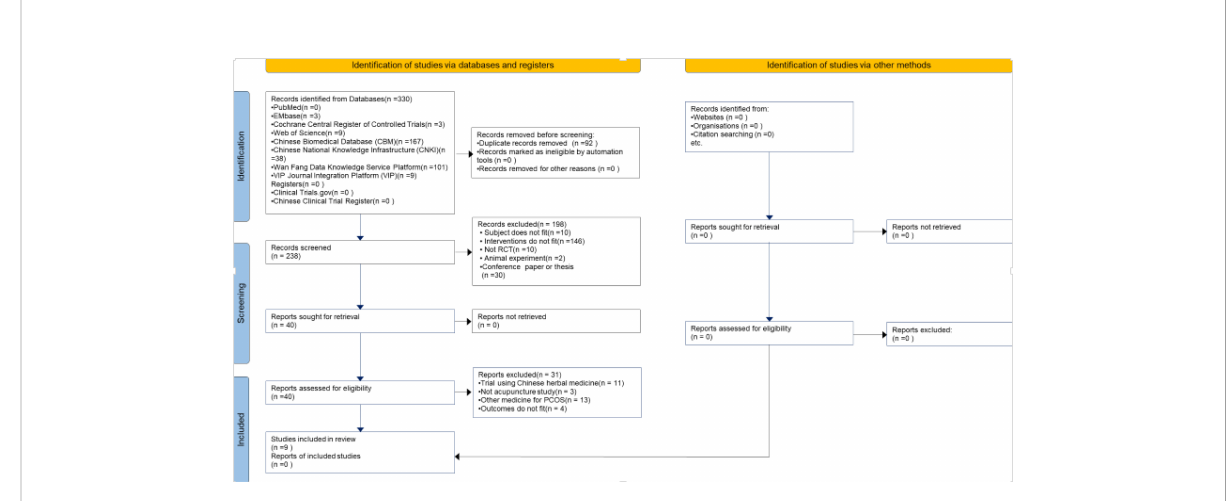
FIGURE 3 Flowchart of the study selection process.